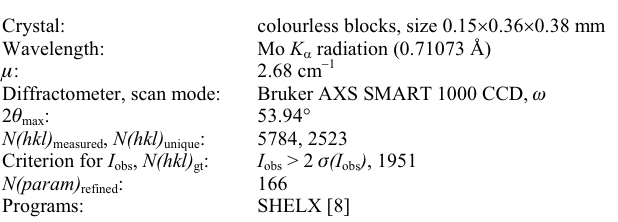
Table 1. Data collection and handling.